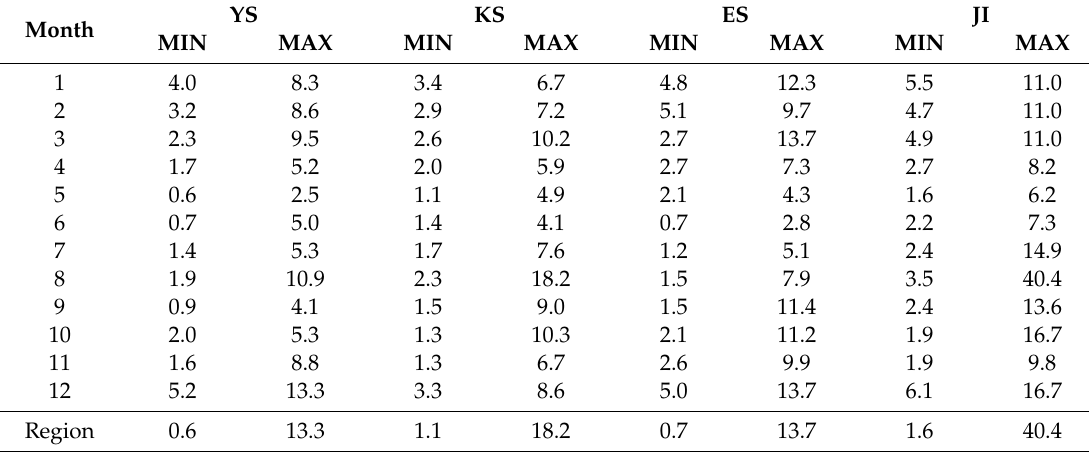
Table 7. Minima and maxima of monthly wave power in the Yellow Sea (YS), Korea Strait (KS), East Sea (ES), and Jeju Island